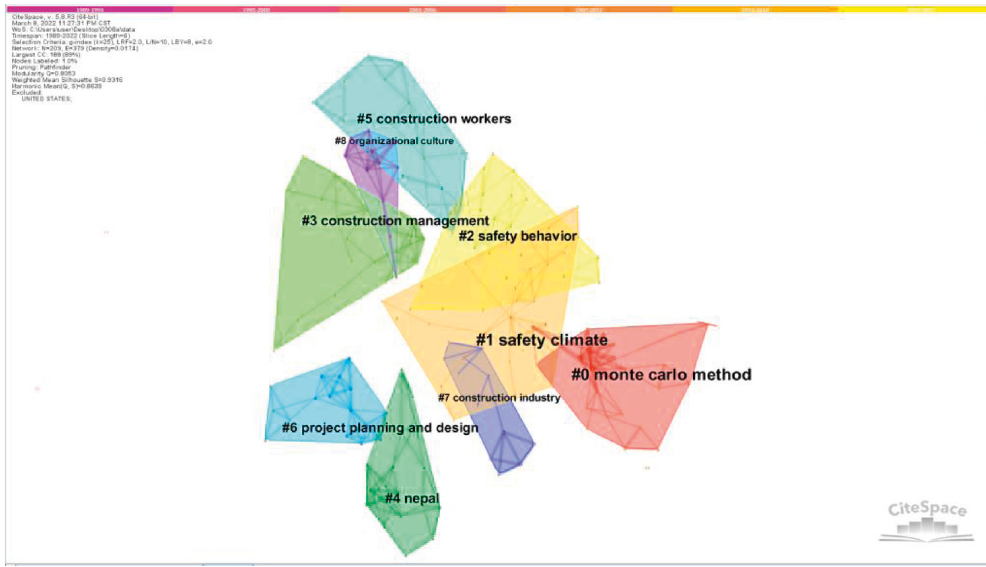
Figure 8: Cluster analysis of culture in construction: